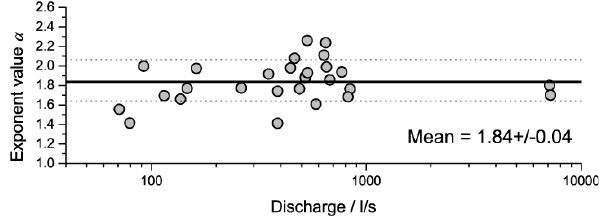
Figure 4. Scaling exponents of the mass distribution as function of discharge for the Erlenbach samples. No trend is visible. The solid line gives the mean value, dotted lines depict one standard deviation around the